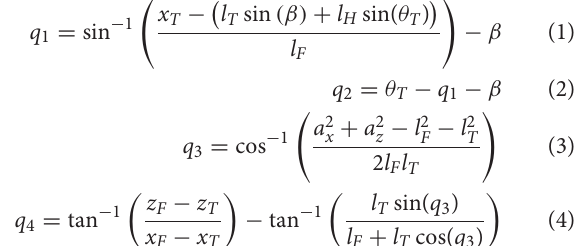
Figure 9E : the basis function f x , f z , the desired step length L , the clearance H , and the step duration t S are inputted to the high-level control, which in turn extrapolates time-continuous reference trajectories in the Cartesian space. Then, the